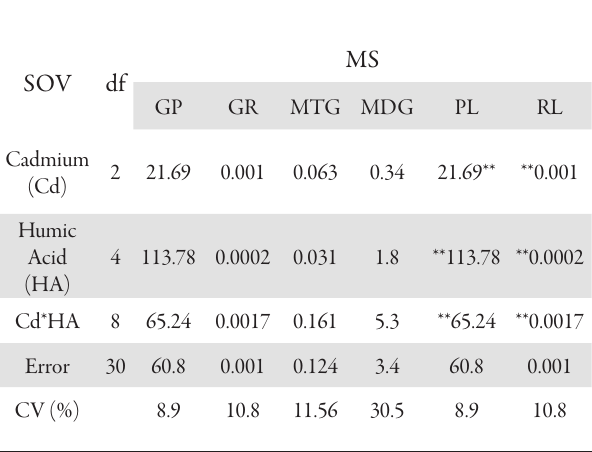
Tab. 1. Analysis of variance table for the effect of cadmium and humic acid on the germination traits of pumpkin